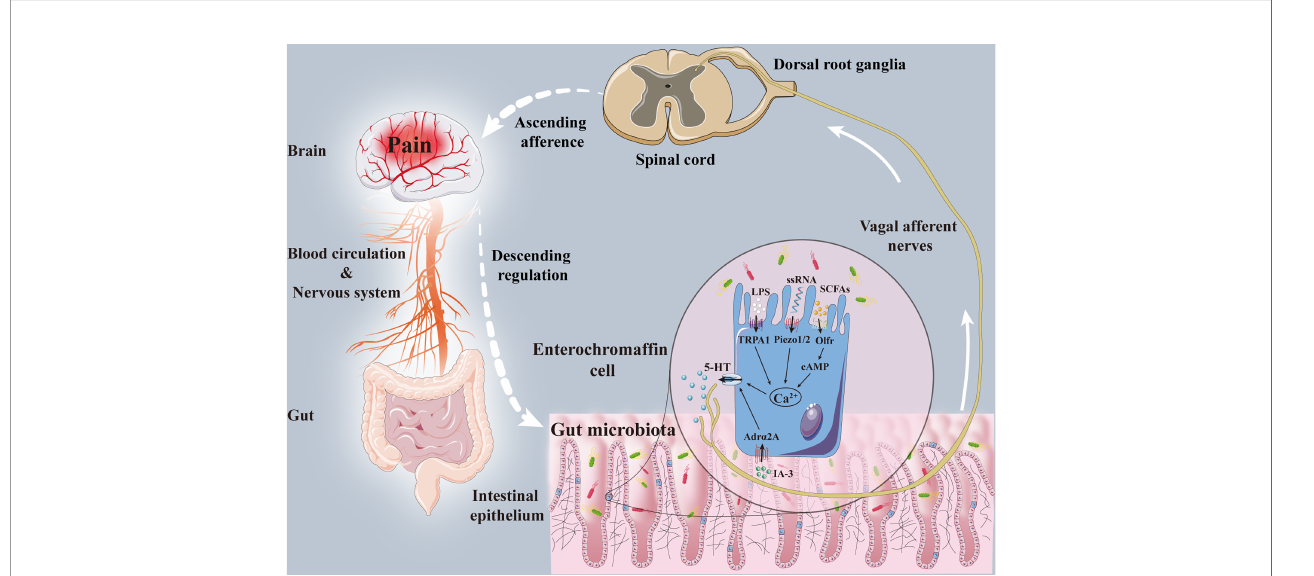
FIGURE 1 | The mechanisms of enterochromaf fi n cells in the interaction between gut microbiota and pain. Gut microbiota and its metabolites, including IA-3, ssRNA, SCFAs and LPS, acted on enterochromaf fi n cells receptors (Adr a 2A, piezo1/2, cAMP, Olfr, TRPA1) to induce the release of 5-HT. Part of 5-HT transferred hyperalgesia signals to dorsal root ganglia and spinal dorsal horn through the vagal afferent nerve. Pain signals are then transmitted to the brain through the spinal- thalamic tract and other ascending afferent tracts, and eventually integrated through the cerebral cortex and limbic system. After that, the brain can regulate pain sensation through descending regulation and neuromediators. Adr a 2A, a 2A adrenoreceptor; cAMP, cyclic adenosine monophosphate; IA-3, autoinducer 3; LPS, lipopolysaccharide; Olfr, olfactory receptor; SCFAs, short-chain fatty acids; ssRNA, single-stranded RNA; TRPA1, transient receptor potential A1; 5-HT,